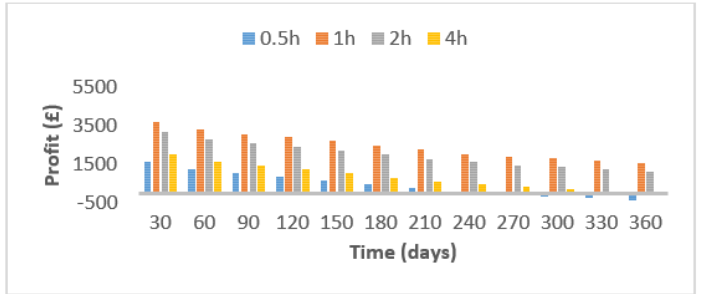
Figure 9. Profitability of the four de-rated batteries over 1 year when λ cl = £27.5/kW/year .